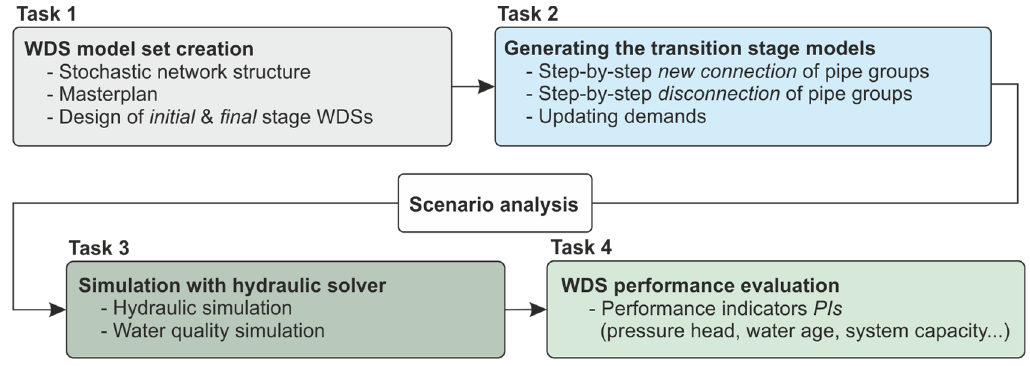
Figure 1. Description of the modelling framework.